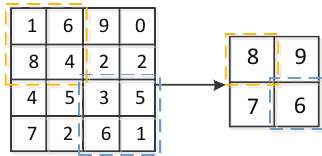
Figure 6. Maximum pooling